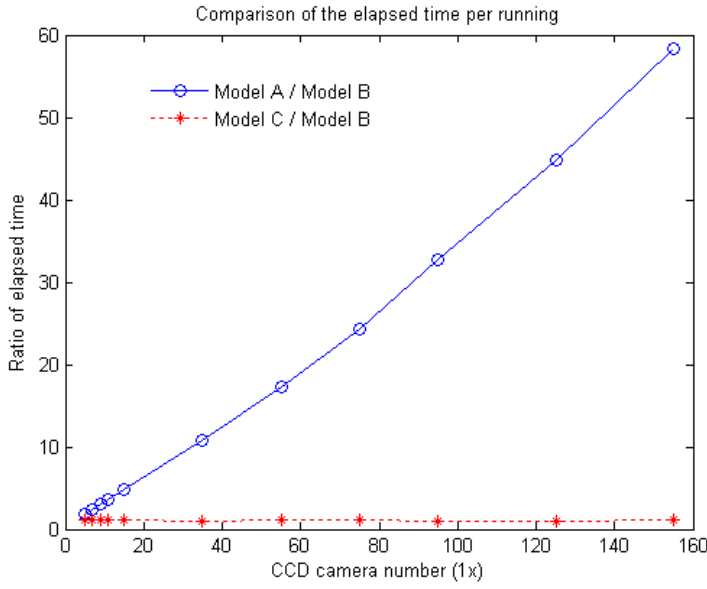
Figure 6. The elapsed time per running of translation motion in three Models with fifty 3D points under a noise level of variance